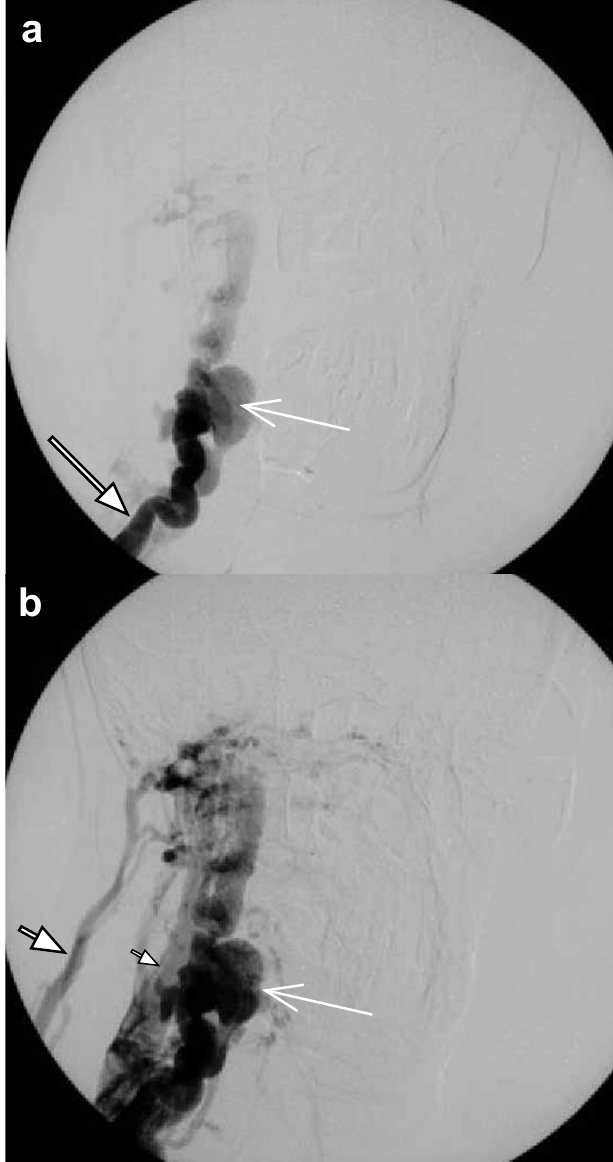
Figs 4a and 4b. DSA of the right vertebral artery, confirming the cervical spinal AVF (open arrow), demonstrating the intricate web of communications between the dysplastic right vertebral artery (filled arrow) and the right internal (smaller arrow head) and external jugular (larger arrowhead) veins.